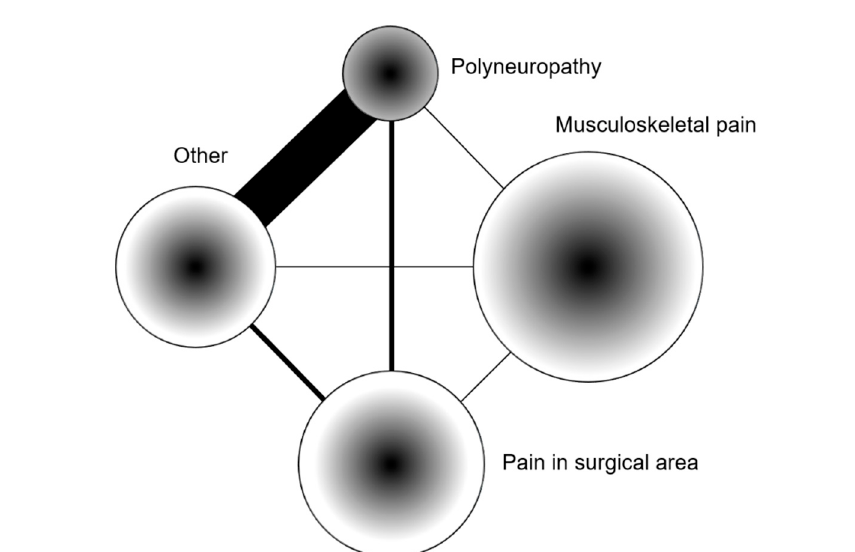
Figure 3. Network plot reporting the numbers of patients reporting pain in different categories (size), the proportion of reported pain permanence (gradient: black—permanent; white—non-permanent), and the frequency of their co-occurrence (lines thickness indicates the closeness of the relationship, based on the inverse Ward distance).